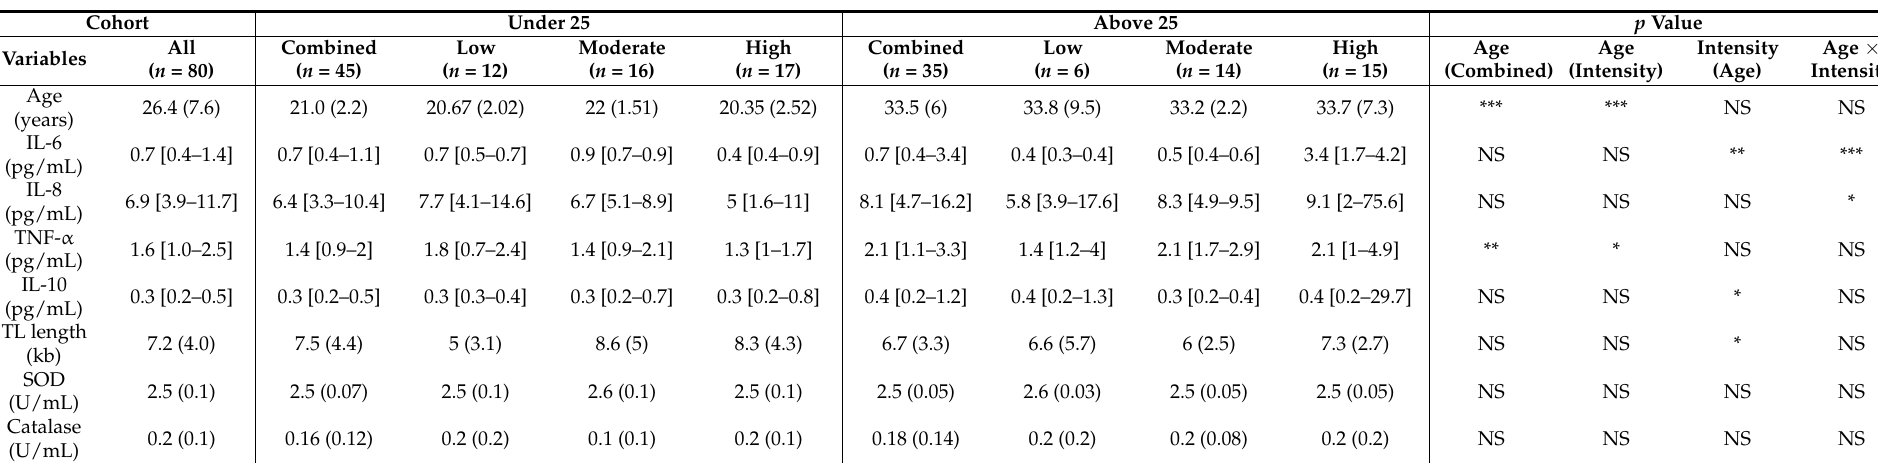
Table 2. Comparing cytokines, antioxidant enzymatic activities and telomere length (TL) in younger (under 25 years old) and older (above 25 years old) elite athletes who belong to different sport intensities (low, moderate and